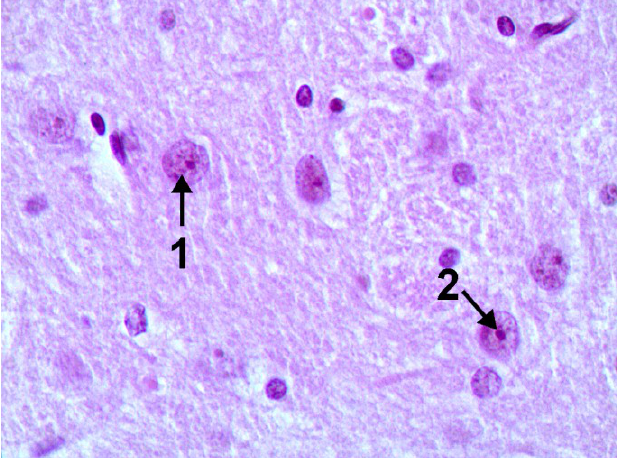
Figure 7. The brain of a control rat, the nucleus caudatus area (hematoxylin-eosine stain, magnification ×400). The neuron nuclei are predominantly spherical with